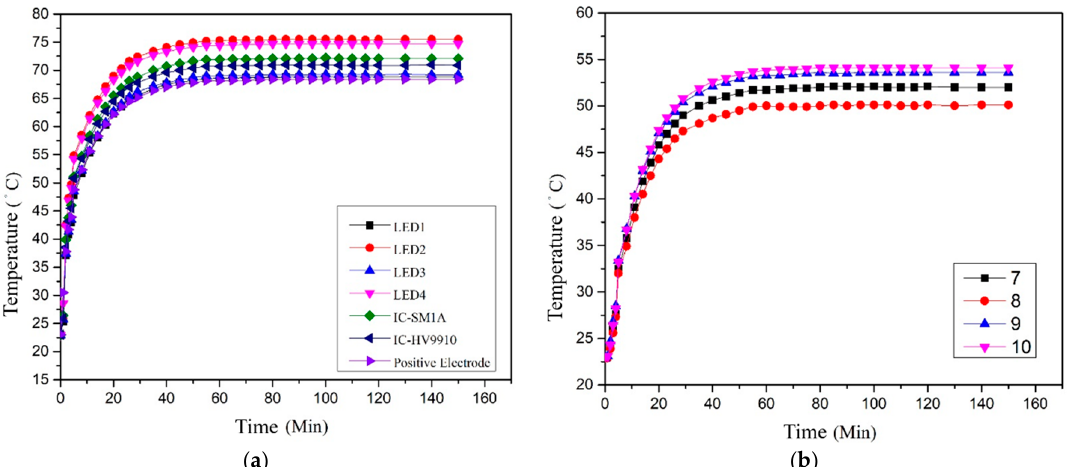
Figure 5. Temperature measurement of 48 V/ 0.15 A LED. ( a ) LED internal temperature field. ( b ) Aluminum fin temperature field. Appl. Sci. 2020 , 10 , 197 12 of 19